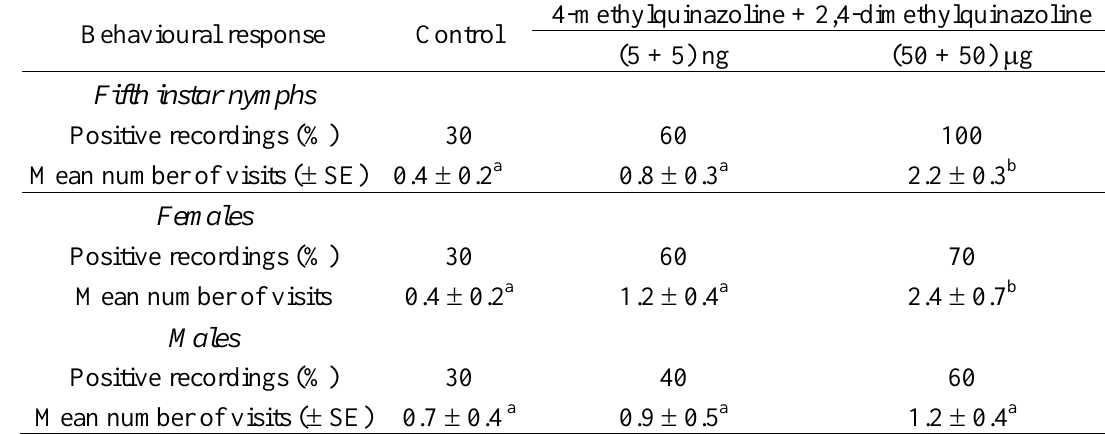
Table 1. Behavioural response of fifth instar nymphs and adults of T. infestans to